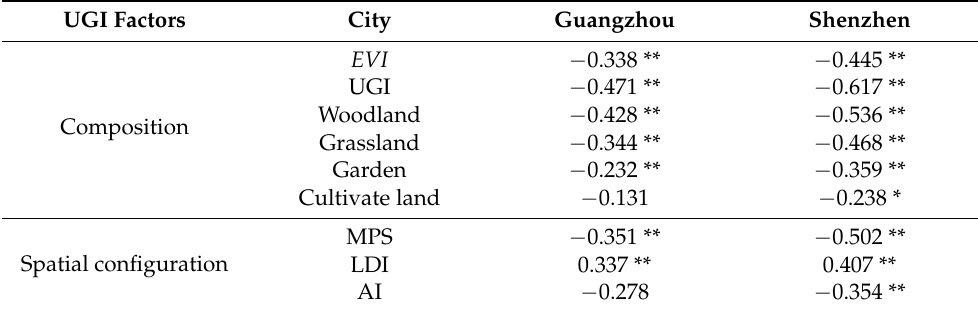
Table 6. Partial correlation coefficients between UGI and